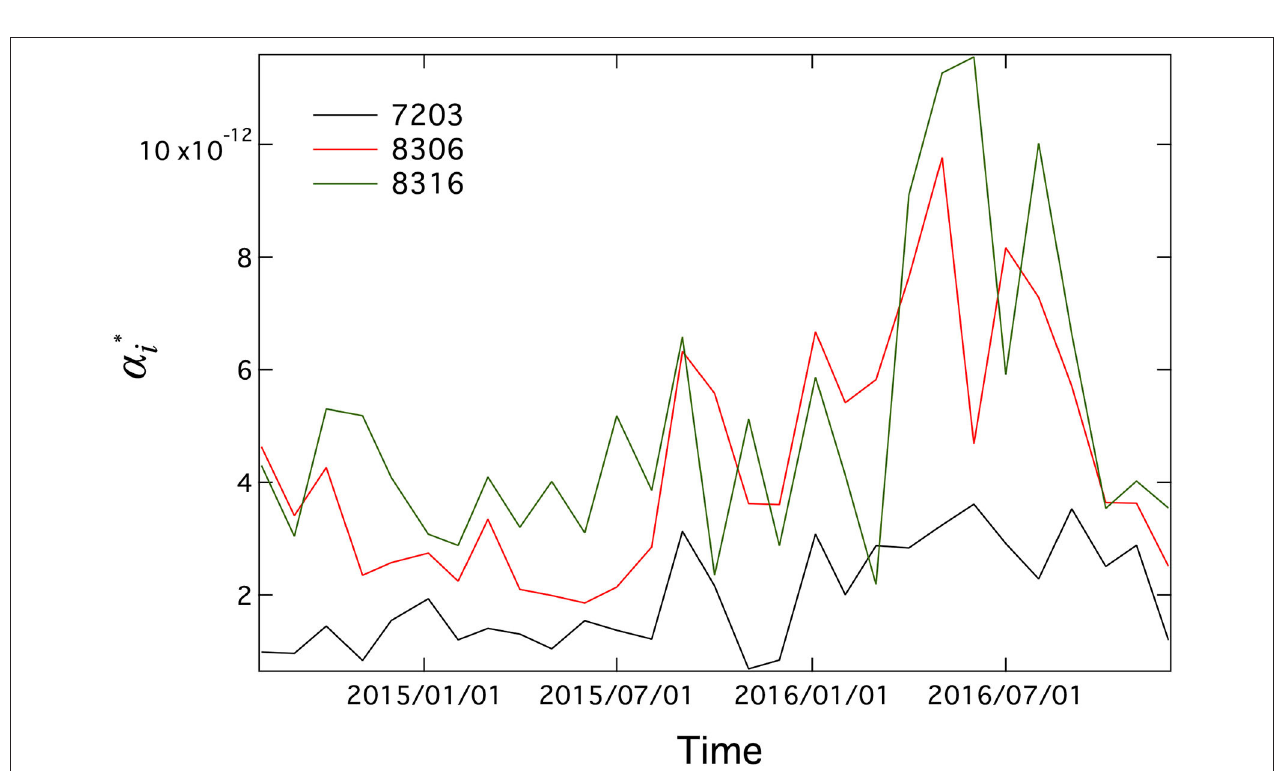
FIGURE 3 | Monthly time series of α * i during 29-month period for three companies: Toyota Motor Corp. (7203), Mitsubishi UFJ Financial Group, Inc. (8306), and Sumitomo Mitsui Financial Group, Inc. (8316).